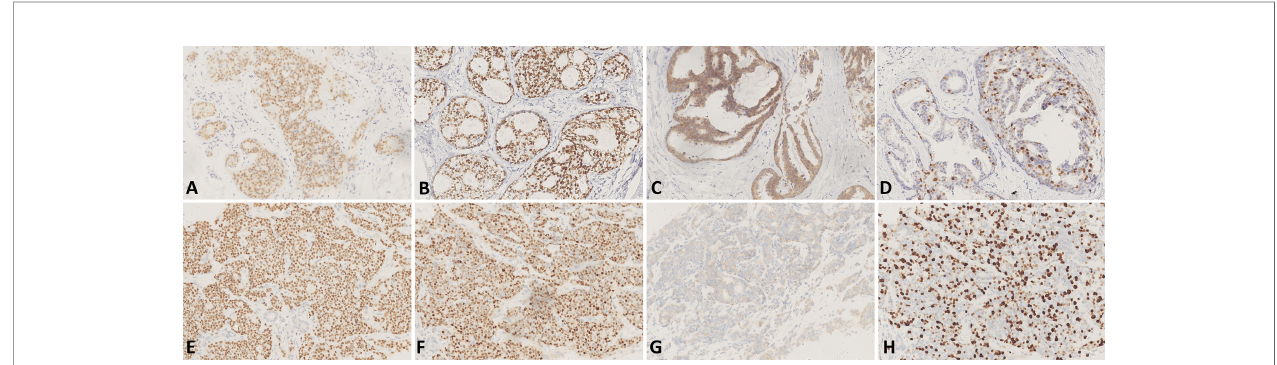
FIGURE 1 | (A – D) IHC of the tissue of excisional biopsy of the right breast in 2012 [×200, (A) IHC for ER, (B) IHC for PR, (C) IHC for HER2, and (D) IHC for Ki-67]. (E – H) IHC of the tissue of liver biopsy in 2017 [×200, (E) IHC for ER, (F) IHC for PR, (G) IHC for HER2, and (H) IHC for